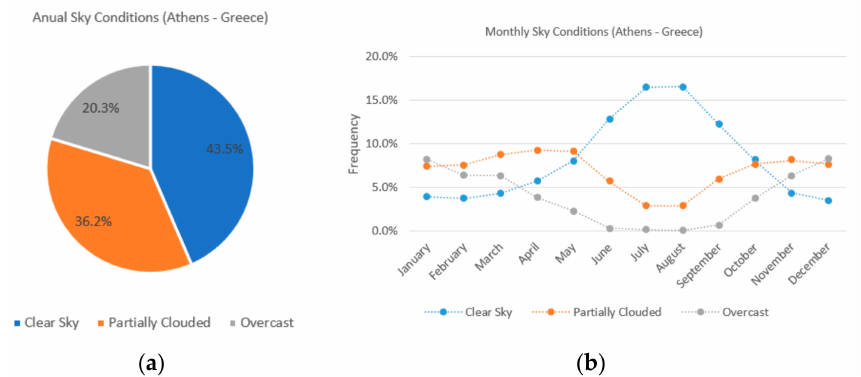
Figure 7. Typical ( a ) annual and ( b ) monthly sky conditions in Athens.